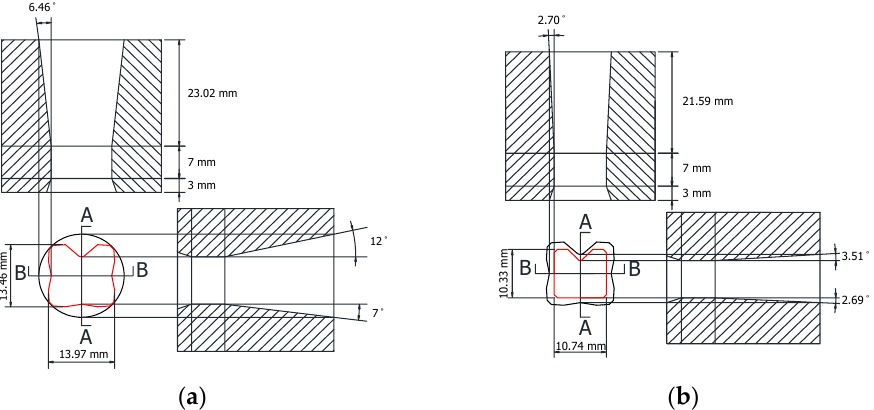
Figure 7. Geometry of the drawing dies designed using the ERV method for the cross-roller guide: ( a ) first pass; ( b ) second pass.